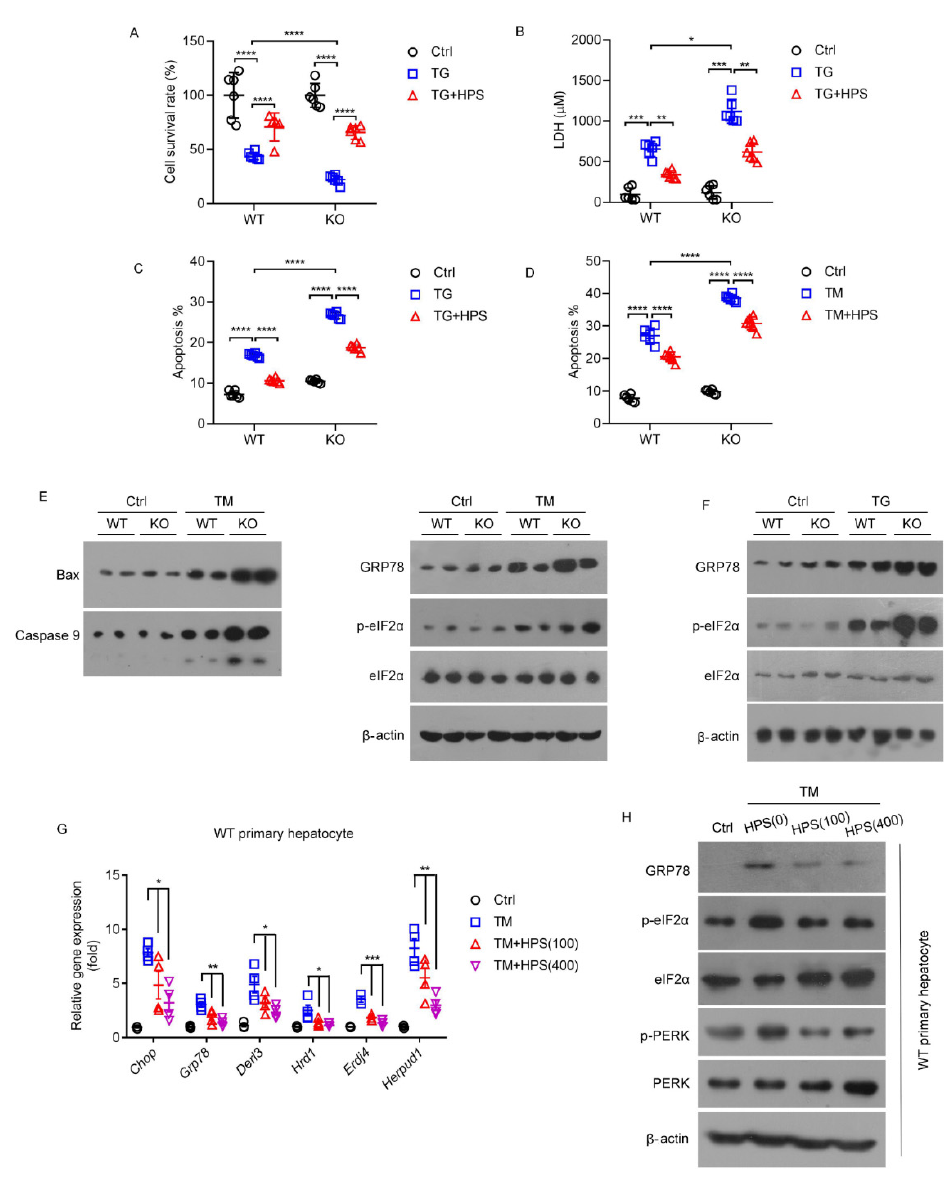
Figure 2. HPS is responsible for ER stress protection in hepatocytes in vitro. For panel ( A – C ), WT or HPS-KO primary hepatocytes were treated with HPS (400 ng/mL, 8 h) and TG (15 μ M, 5 h). ( A ) MTT was performed to detect cell survival. ( B ) ELISA was performed to determine LDH levels in primary hepatocytes culture media. ( C ) Flow cytometry was performed to analyze percentages of apoptosis. For panels ( D – F ) WT or HPS-KO primary hepatocytes were treated with HPS (400 ng/mL, 2 h) and TM (4 μ g/mL, 12 h). ( D ) Flow cytometry was performed to analyze percentages of apoptosis. ( E , F ) Immunoblotting of the protein levels of pro-apoptotic protein (BAX and CASPASE 9) and ER stress marker (GRP78, p-eIF2 α and eIF2 α ). Q-PCR ( G ) and immunoblot ( H ) analysis of ER stress markers in WT primary hepatocytes treated with HPS (100 or 400 ng/mL, 2 h) and TM (4 μ g/mL, 12 h). Data are expressed as mean ± SEM of at least three independent experiments (two duplicates per experiment). For panel ( A – D ), the significant difference between the mean relative values of two groups was analyzed by Student t test (* p < 0.05, ** p < 0.01, *** p < 0.001, **** p < 0.0001). For panel ( G ), two-way ANOVA was used for statistics ( Chop : F = 59.44, * p < 0.0126; Grp78 : F = 47.16, *** p = 0.0002; Derl3 : F = 18.28, ** p = 0.0028; Hrd1 : F = 10.36, * p = 0.0113; Erdj4 : F = 23.49, ** p = 0.0062; Herpud1 : F = 57.52, *** p = 0.0001).